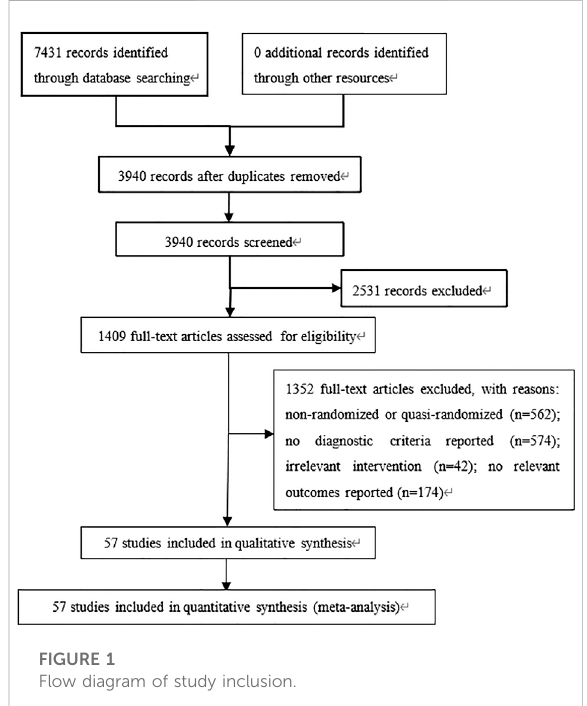
FIGURE 1 Flow diagram of study